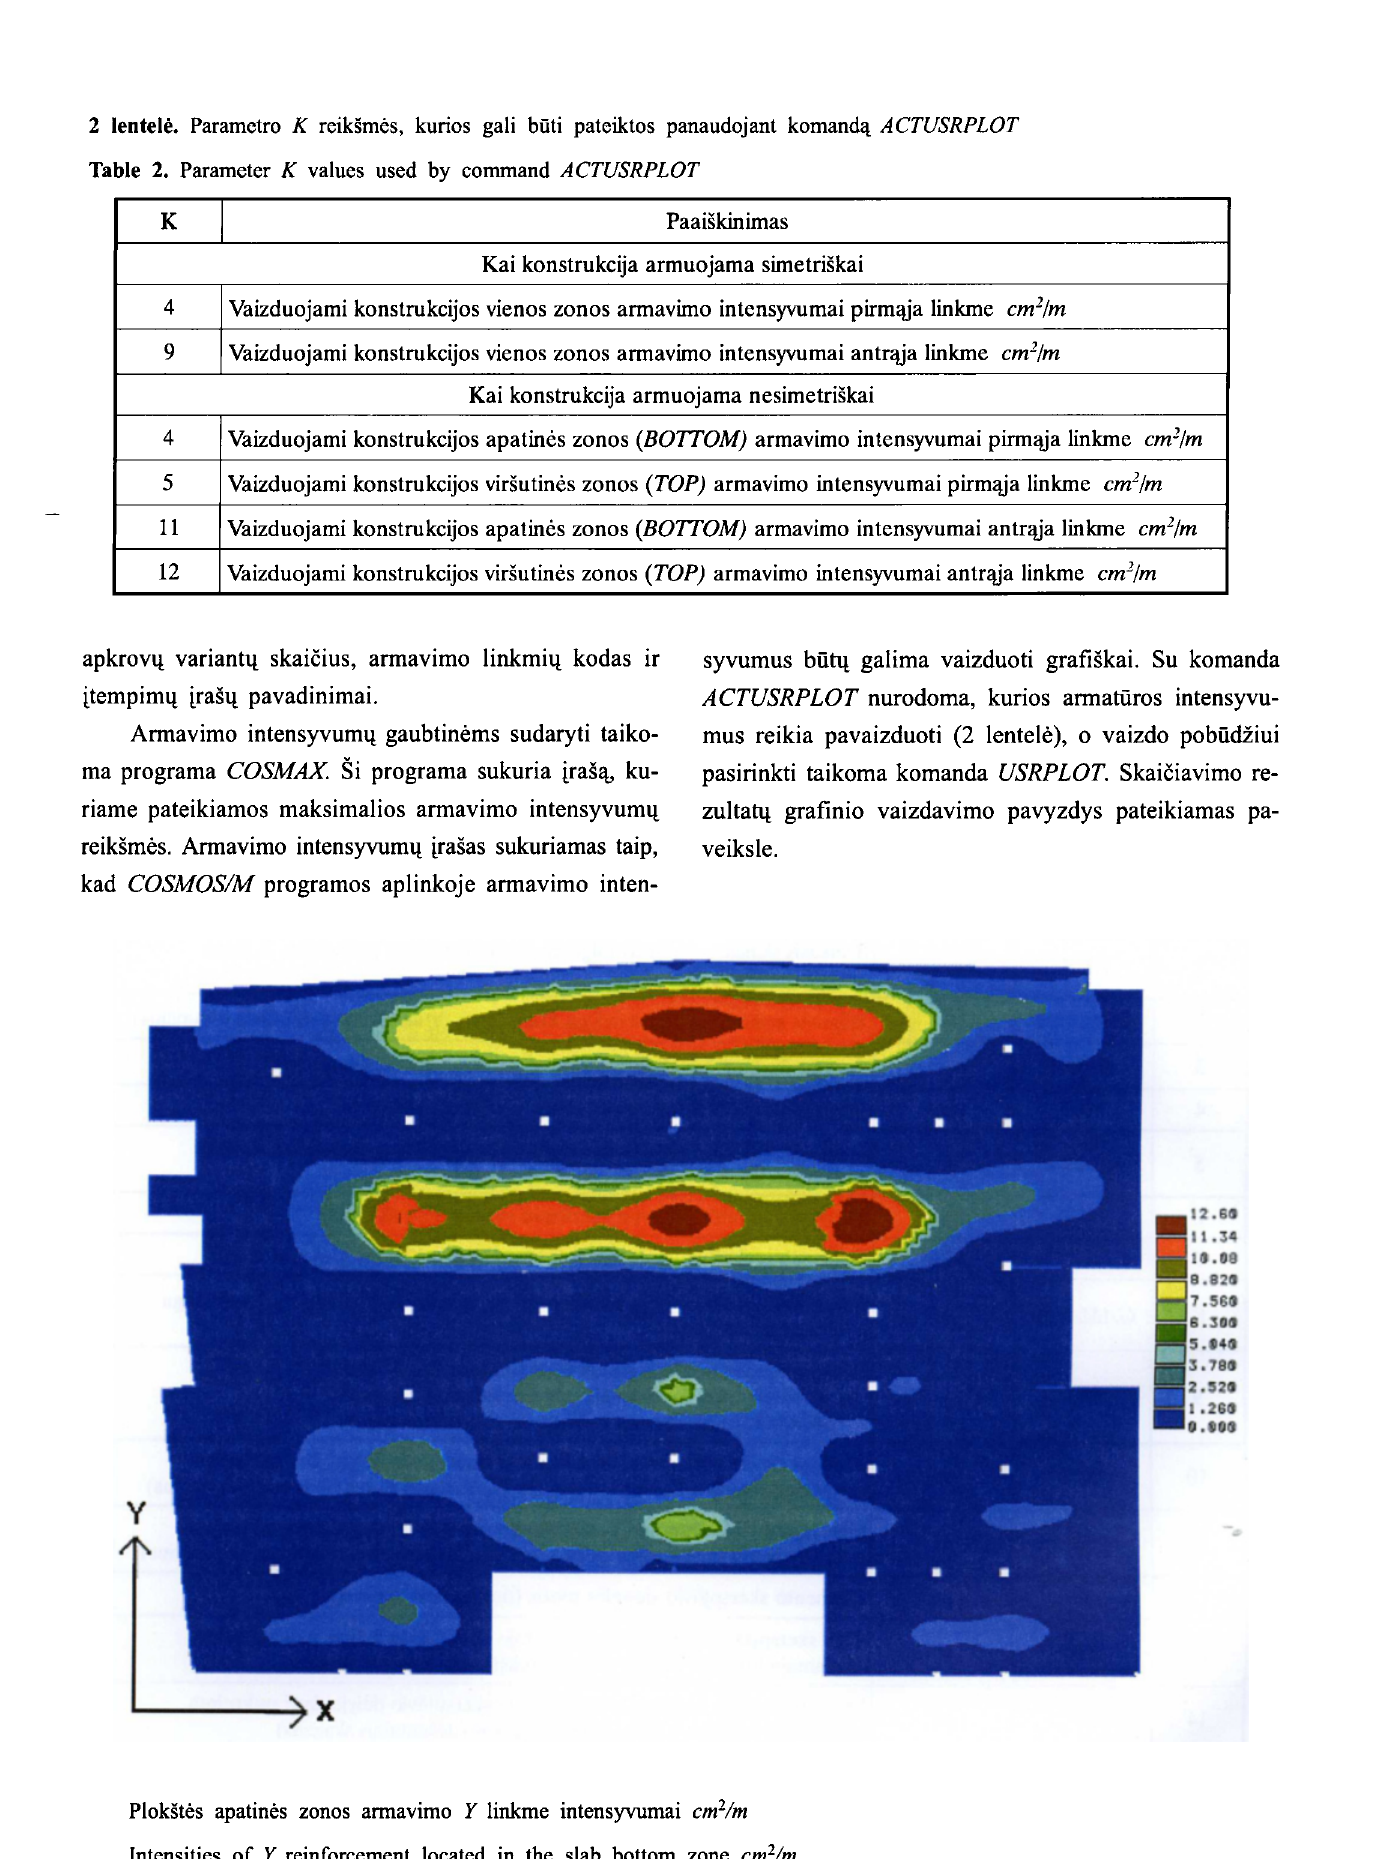
Intensities of Y reinforcement located in the slab bottom zone cm 2 /m